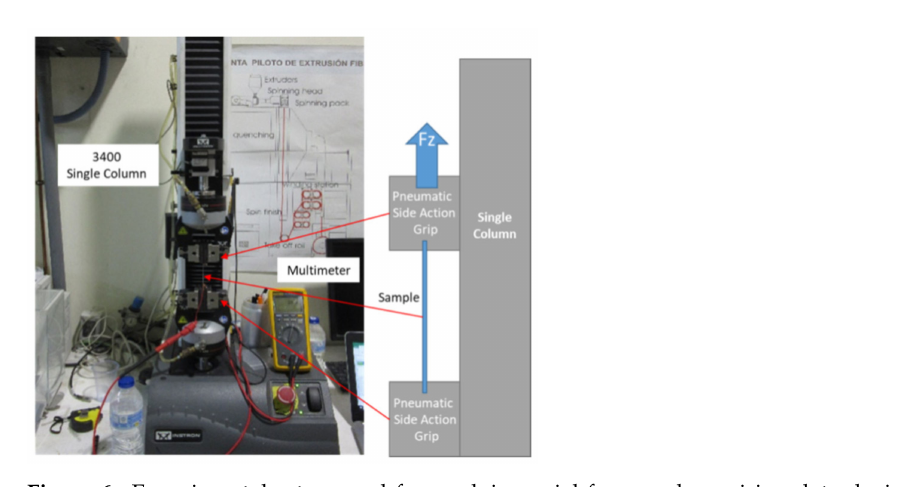
Figure 6. Experimental setup used for applying axial force and acquiring data during the elec- trode